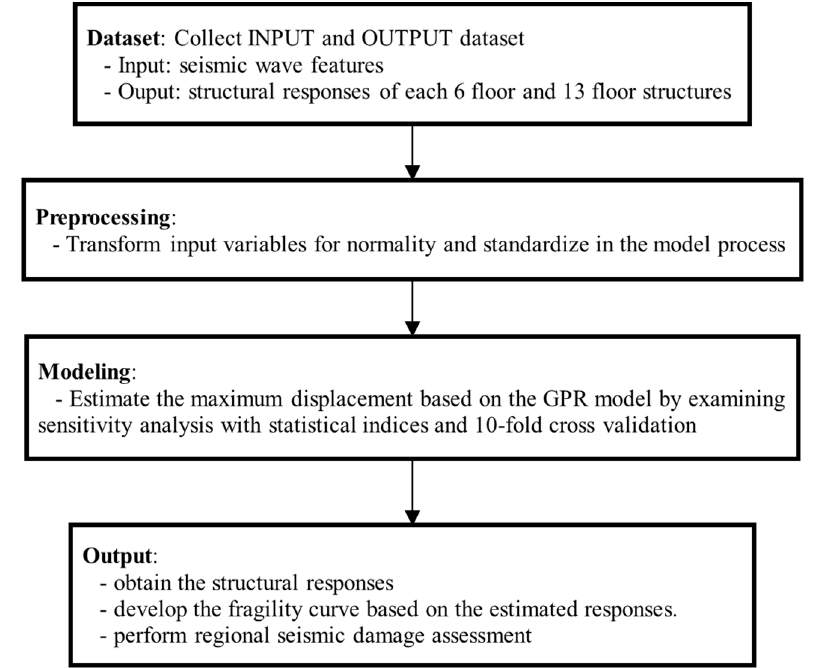
Figure 1. Procedure for obtaining the maximum displacement and fragility curves. 3. Data